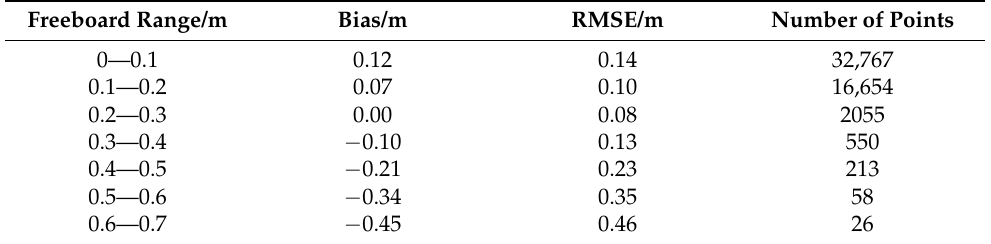
Table 5. Bias between the freeboard from this study and that from CCI in different freeboard ranges. Freeboard Range/m